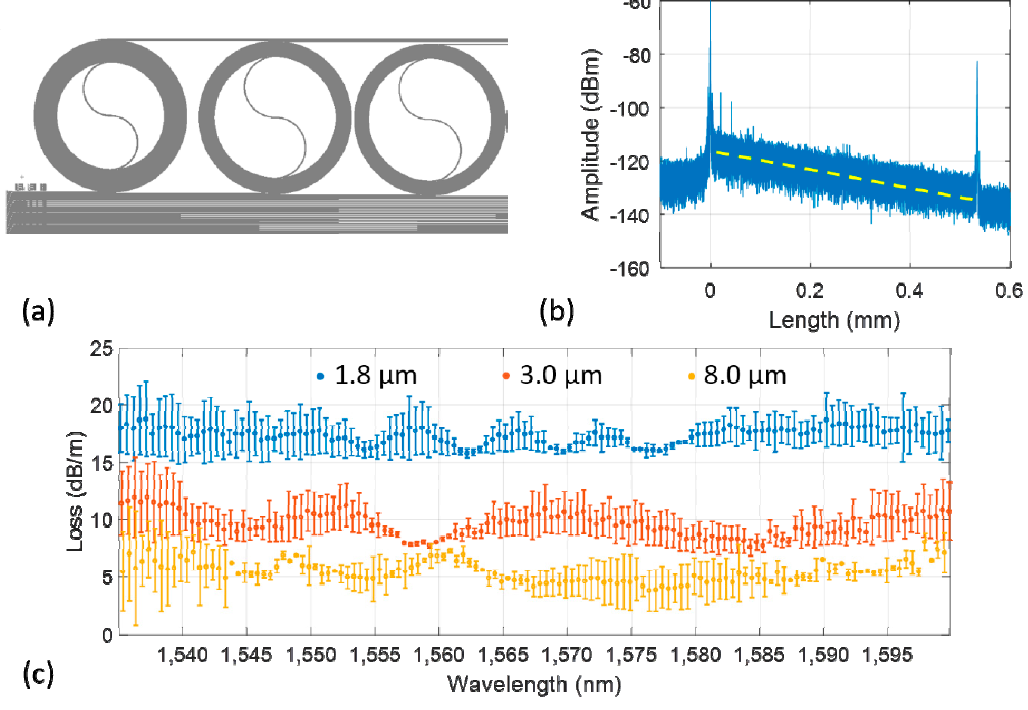
Figure 4. ( a ) Mask layout of spiral delay lines with 52.2 cm total length and 850 µm minimum bend radius ( b ) Optical Backscatter Reflectometry (OBR) data from the spiral with 1.8 µm width. A linear fit of the waveguide backscatter is shown with the dashed red line. The propagation loss of the waveguide can be approximated as 1/2 of the slope of the fitted line. ( c ) Wavelength dependence of the propagation loss (mean and standard deviation) of waveguides with different widths (1.8 µm, 3.0 µm and 8.0 µm).